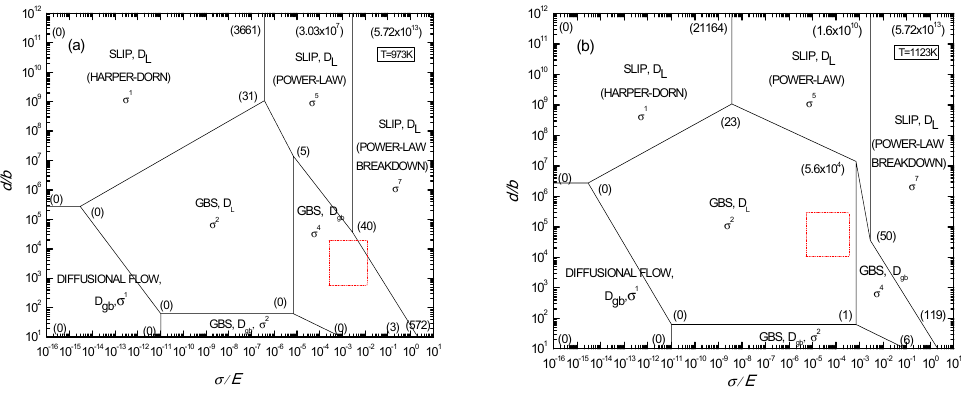
Figure 8. Rate controlling deformation mechanism maps for two-phase titanium alloy constructed at 973 K ( a ) and 1123 K ( b ).